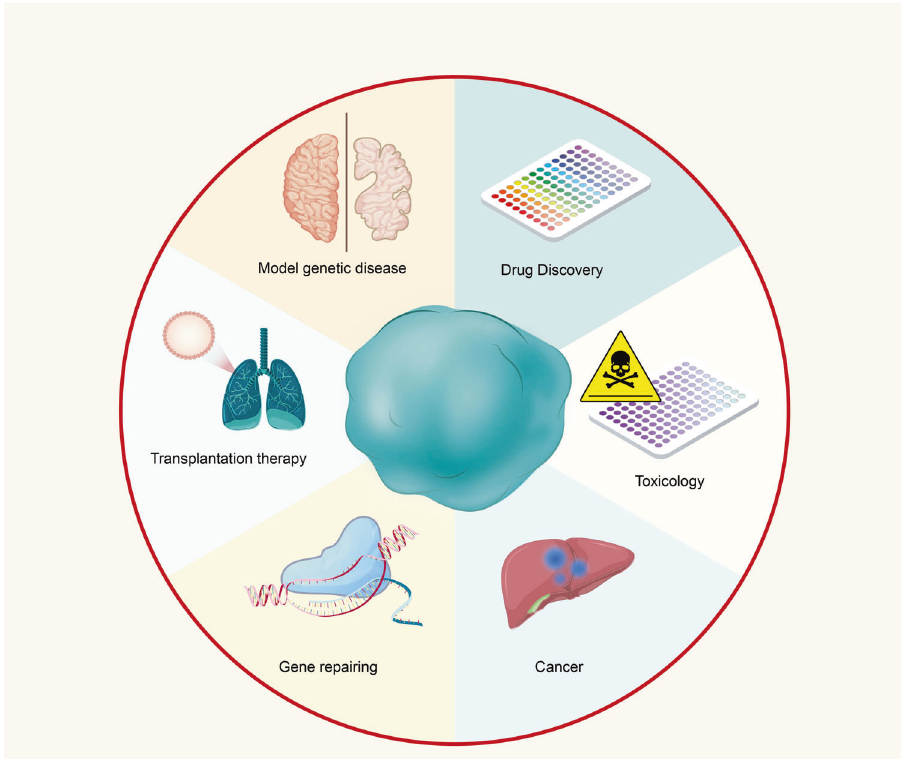
Fig. 5 Various applications of organoid technology. Schematic depiction of various applications of organoid technology based on the studies mentioned above. Organoid technology provides ideal models mimicking human genetic diseases caused by induced mutations. By using gene editing techniques such as CRISPR/Cas9, researchers could investigate some diseases associated with genetic defects. Organoid technology has also provided a potential tool for high-throughput drug discovery and enables accurate toxicity testing and preclinical studies. Recent advances in cancer research within organoids are opening the way for promising organoid transplantation therapy in the